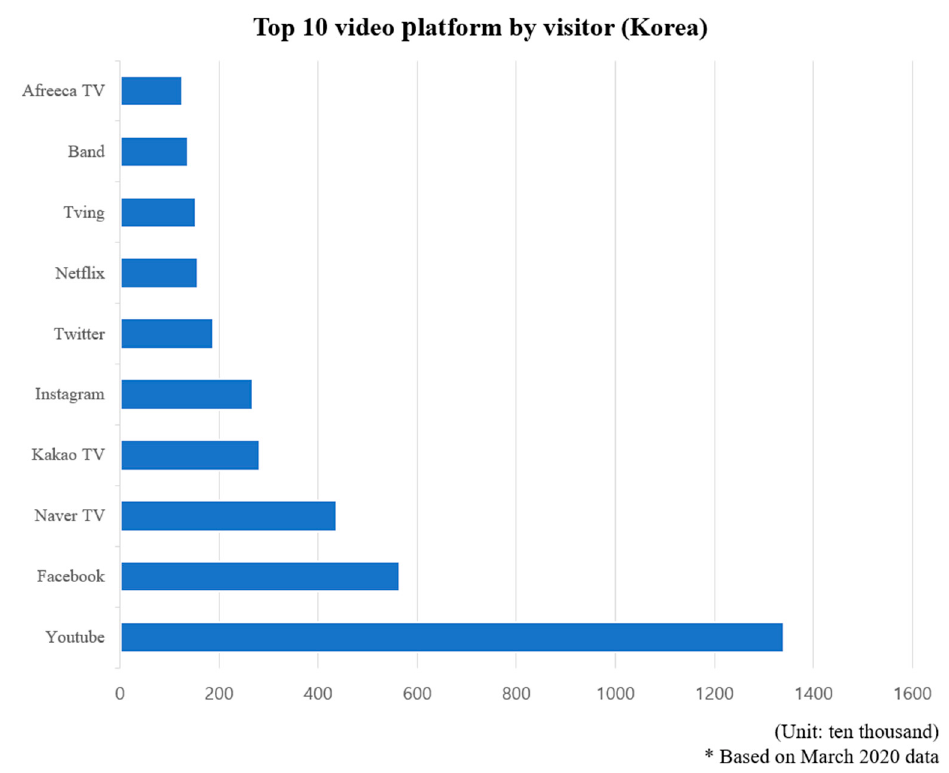
Figure 1. Top 10 video platforms in terms of the number of visitors in Korea.